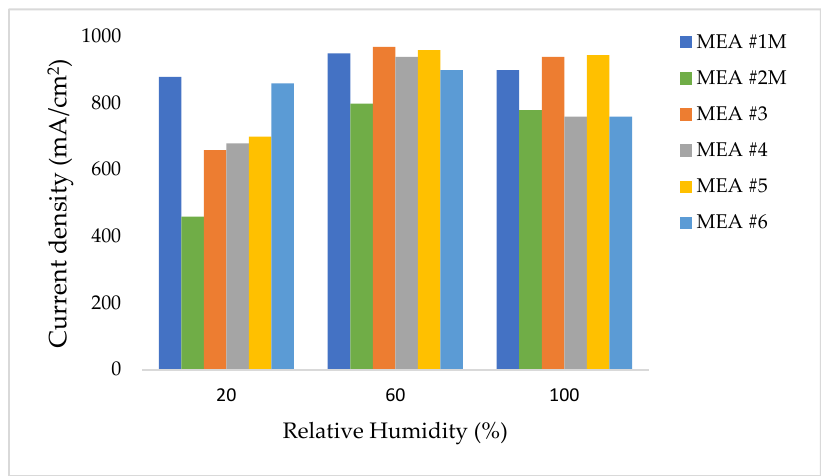
Figure 3. The current density (mA/cm 2 ) for the stratified and non-stratified MEAs determined at 20–100% RH and 0.65 V.